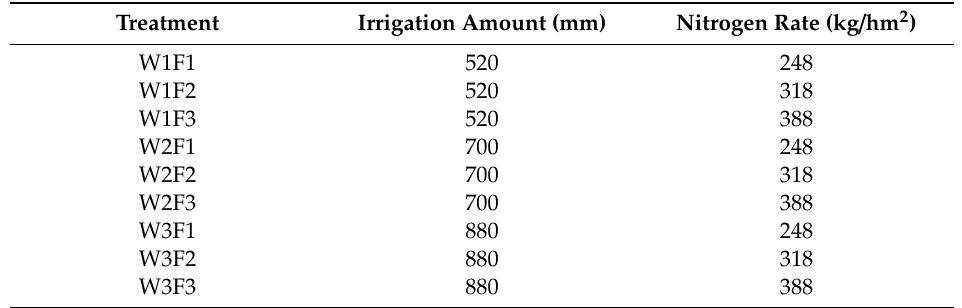
Figure 2. Jujube row spacing in Xinjiang ( a ); jujube plant spacing in Xinjiang ( b ); jujube planting model in Xinjiang ( c ). Table 1. Experimental design of irrigation amount and nitrogen rate in full growth period in Xinjiang.